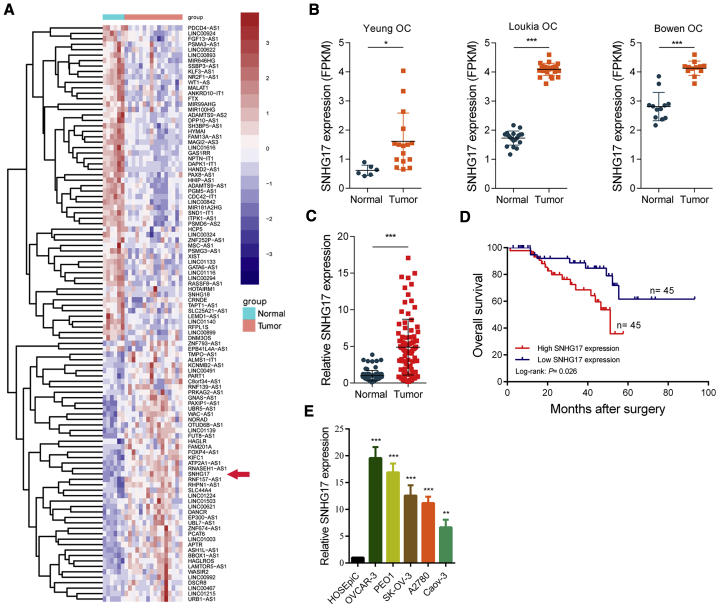
SNHG17 Is Upregulated in OC, and a High SNHG17 Expression Predicts a Poor Prognosis(A) Heatmap of aberrantly expressed lncRNAs in OC (GEO: GSE54388). Red in the heatmap indicates upregulation, and blue indicates downregulation. The red arrow denotes SNHG17. (B) The expression of SNHG17 in the Yeung OC cohort (GEO: GSE54388), Loukia OC cohort (GEO: GSE38666), and Bowen OC cohort (GEO: GSE14407). (C) qRT-PCR analysis of SNHG17 expression in 90 pairs of OC and corresponding adjacent normal tissues. (D) Kaplan-Meier analysis of OC patients’ overall survival based on SNHG17 expression (n = 90; p = 0.026); a tissue sample whose threshold cycle (CT) value of SNHG17 minus a CT value of GAPDH less than −6.46 was defined as high SNHG17 expression. (E) qRT-PCR analysis of SNHG17 expression in OC cell lines (OVCAR-3, PEO1, SK-OV-3, A2780, and Caov-3) and normal human ovarian surface epithelial cells (HOSEpiCs). ∗p < 0.05; ∗∗p < 0.01; ∗∗∗p < 0.001.